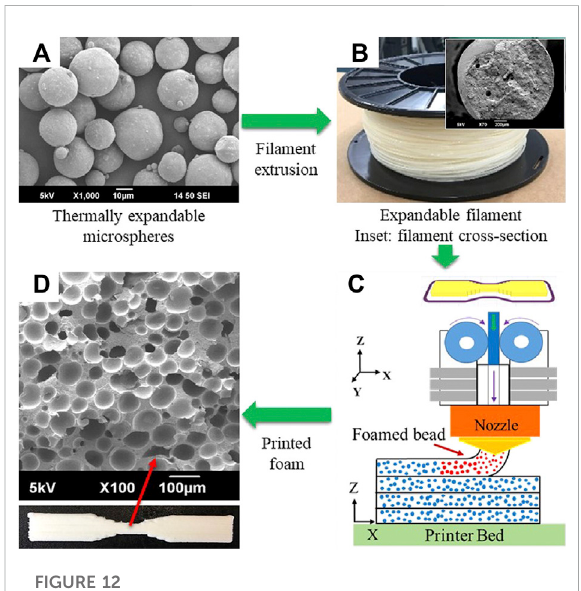
FIGURE 12 Overview of the in situ foam 3D-printing process: (A) TEM particles as blowing agents, (B) extruded expandable fi lament with an inset SEM micrograph showing itscross-sectional view, (C) part designandschematicoftheinsitufoamprintingprocess,and (D) example of the printed tensile sample with a SEM micrograph showingthemicrocellularmorphologyintheY-Zplane.Copyright 2022, American Chemical